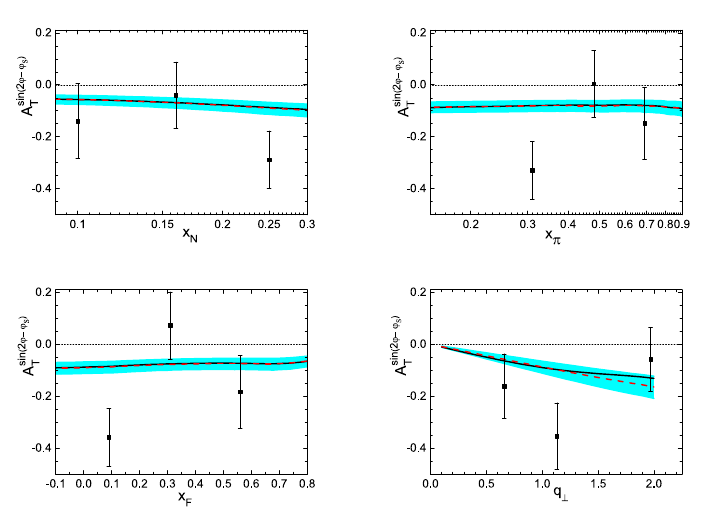
in the π − N ↑ Drell-Yan process calculated from the SIYY Figure 1. The asymmetry A sin(2 φ − φ S ) Figure 2. Similar to Fig. 1, but the asymmetry calculated from the BDPRS parametrization on the T parametrization on the nonperturbative form factor. The four figures correspond to the asymmetries nonperturbative form factor. The dashed lines plot the central results, while the solid lines are the as functions of x N (upper left), x π (upper right), x F (lower left) and q central results in Fig. 1 for comparison. (lower right). The solid lines ⊥ show the results from the central values of the parameters, while the shaded area show the uncertainty bands determined by the uncertainties of the parameters. The solid squares represent the COMPASS data for comparison.